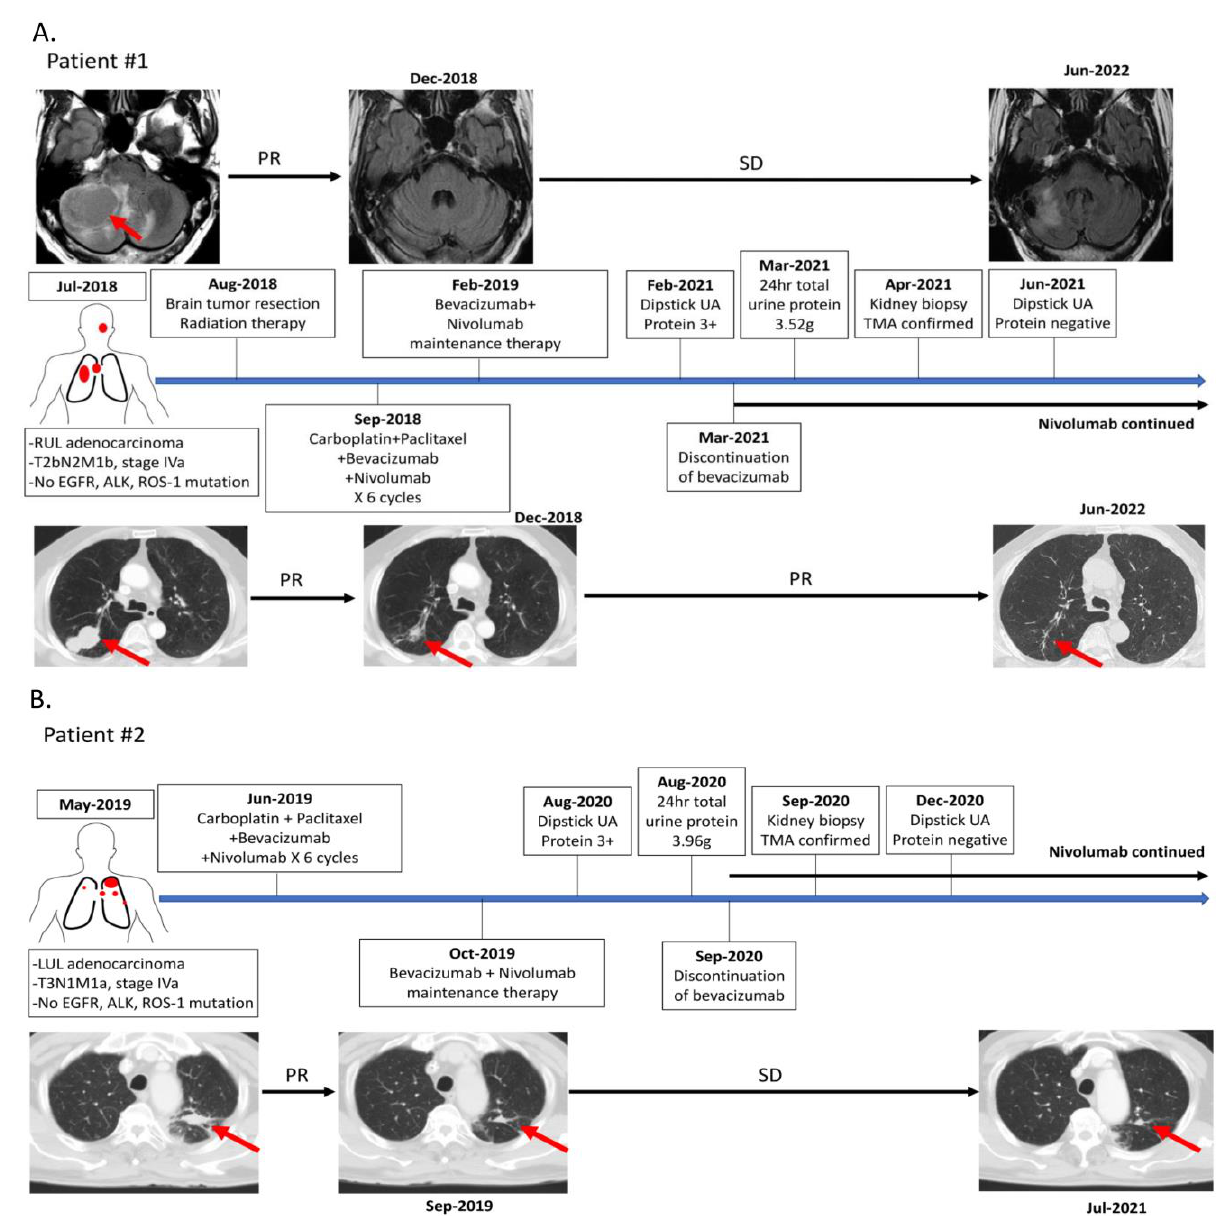
Figure 1. The treatment and follow-up timeline summary of 2 patients. The primary lung cancer and metastatic tumor are labeled by red arrow. ( A ) The treatment and follow-up timeline summary of patient #1. ( B ) The treatment and follow-up timeline summary of patient #2. Abbreviations: EGFR, epidermal growth factor receptor; ALK, anaplastic lymphoma kinase; PR, partial response; SD, stable disease; UA, urine analysis.